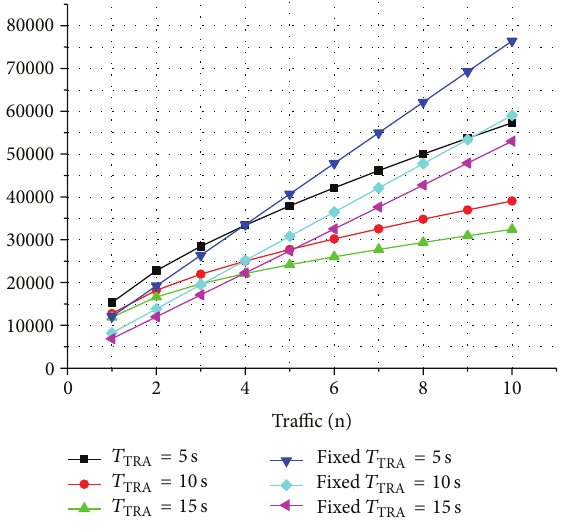
Figure 6: Energy